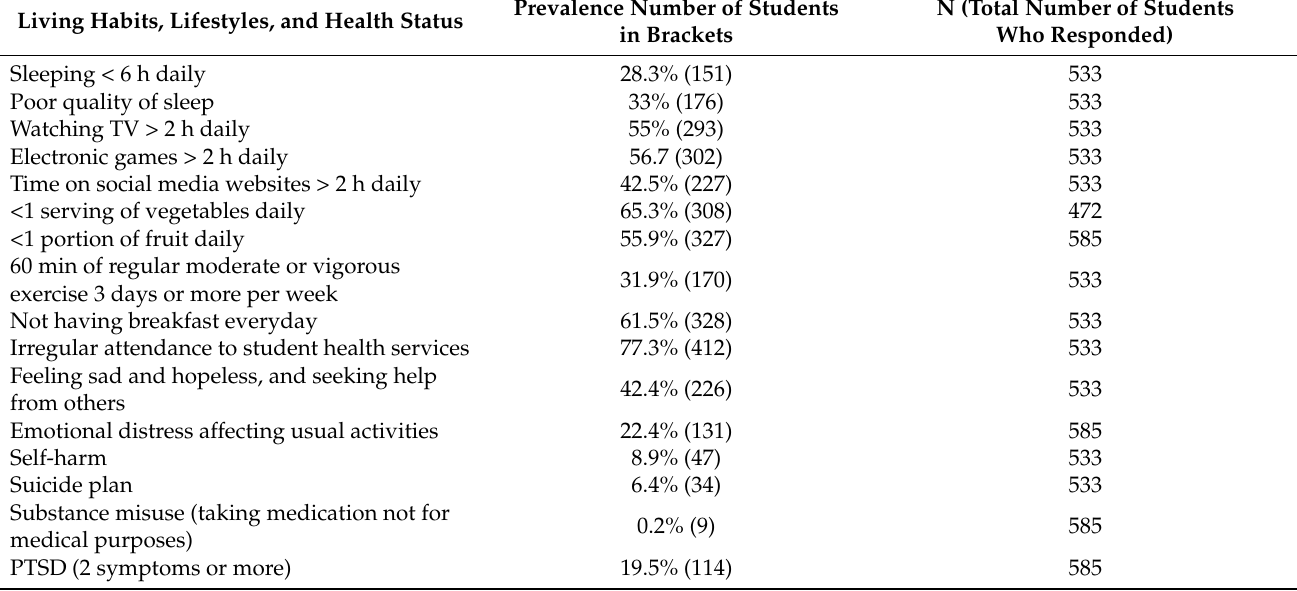
Table 1. Prevalence of living habits, lifestyles, and health status (N = number of students responding to the question with a valid answer).